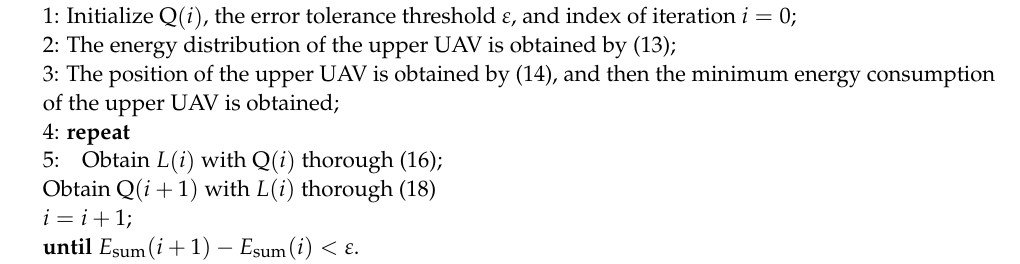
Algorithm 1. Time Resource Allocation